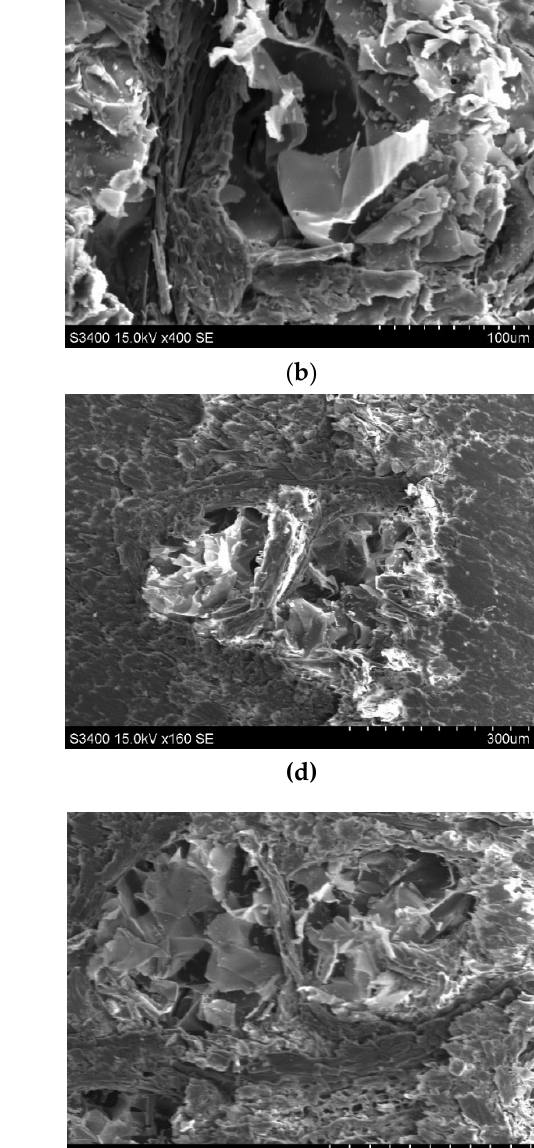
(f) Figure 15. tan δ with temperature: ( a ) control sample – radial cross-section; ( b ) control sample – semi- radial cross-section; ( c ) sample T1 (first treatment) – radial cross-section; ( d ) – sample T1 (first treatment) – semi-radial cross; ( e ) sample T2 (second treatment) – radial cross-section; ( f ) sample T2 (second treatment) – semi-radial cross-section; solid line (50 Hz); long dash dot dot line (10 Hz); dash dot line (5 Hz); square dot line (3.3 Hz); round dot line (1 Hz). 3.4. Scanning Electron Microscope Hitachi S3400N In Figures 16 and 17, the SEM capture of untreated and ammonia treated black locust wood